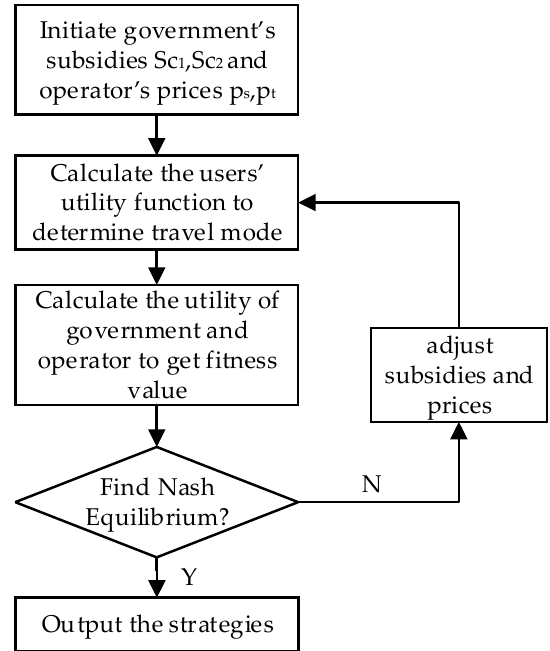
Figure 3. Process of finding Nash equilibrium.